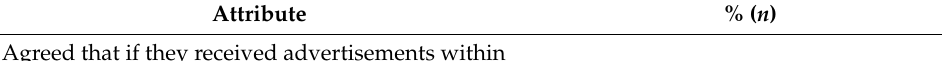
Table 1. Cont. Attribute % ( n ) Agreed that if they received advertisements within websites and apps they already use on their phones 74.6% about healthy options on post, they would be more likely to buy healthy food c